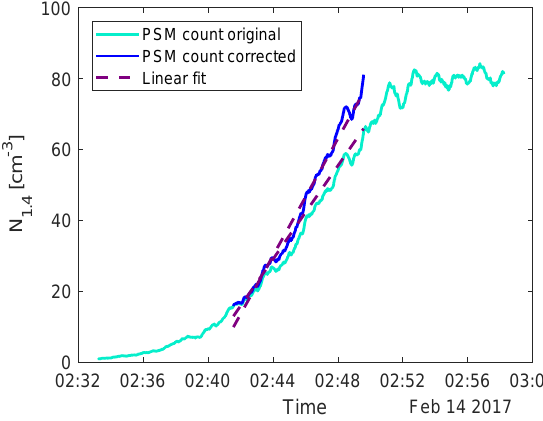
Figure 4. An example of the particle count from the PSM (light blue) and the loss-corrected data (dark blue). The dashed lines show the linear fit between 20 and 80% of the maximum count. The gra- dient of the fit on the corrected data was used as the nucleation rate J 1 . 4 .